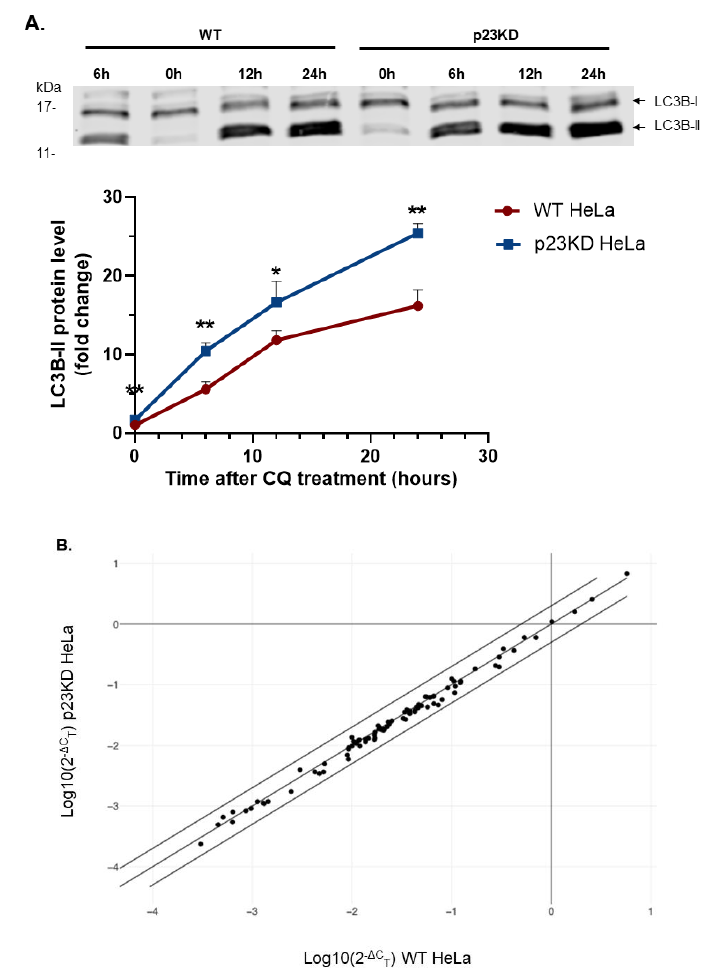
Figure 3. Down-regulation of p23 in HeLa cells exhibits higher autophagic flux. ( A ) Western blot analysis showing that p23 stable knockdown (p23KD) HeLa cells have higher basal LC3B-II protein levels as well as higher autophagic flux than wild type (WT) HeLa cells in the presence of 40 μ M CQ. The graph in A represents replicate data of means ± SD (upper error bars shown), n = 3 of